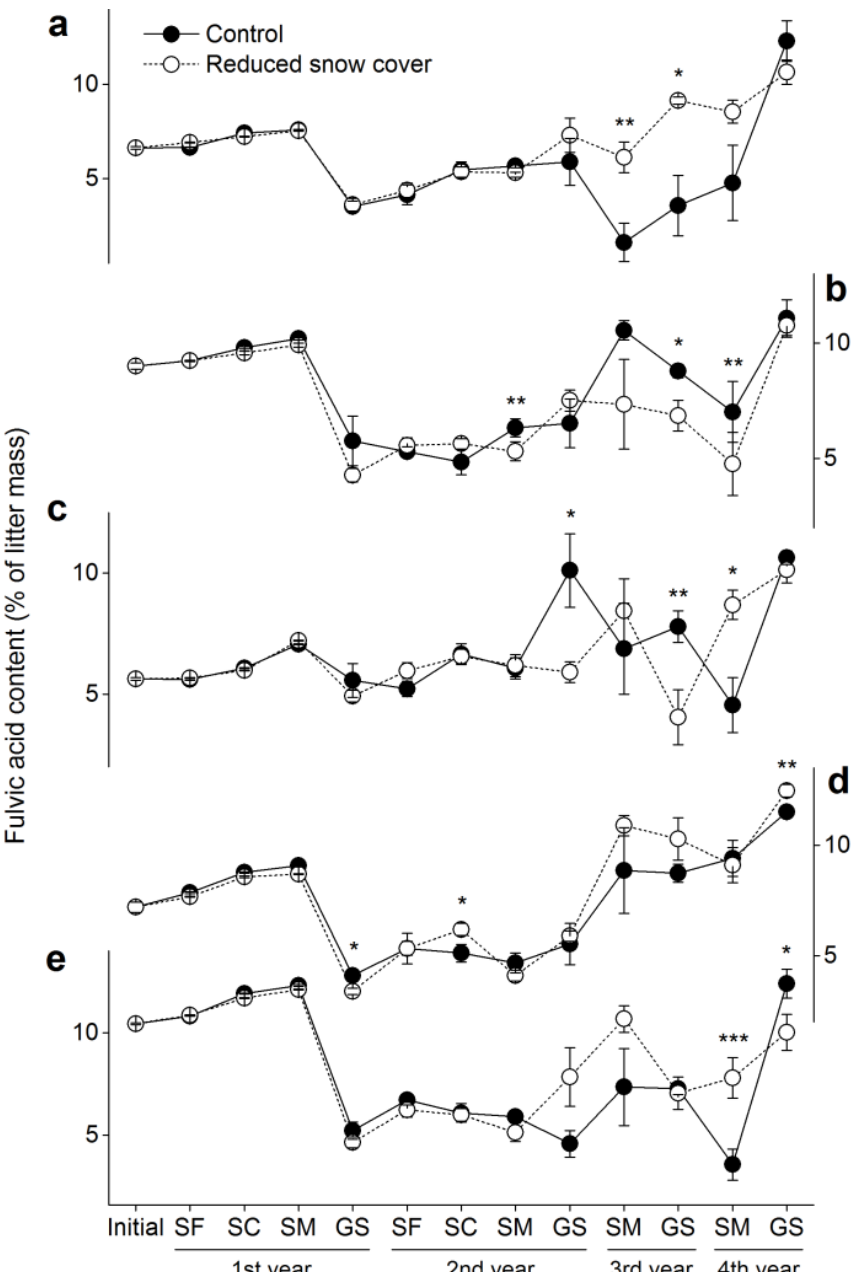
Figure 6. Fulvic acid contents ( ± SE, n = 6) in the five foliar litters. ( a ) Cypress, ( b ) larch, ( c ) birch, ( d ) willow and ( e ) azalea. SF: snow formation stage, SC: snow cover stage, SM: snowmelt stage, GS: growing season. * p < 0.05, ** p < 0.01, *** p < 0.001.